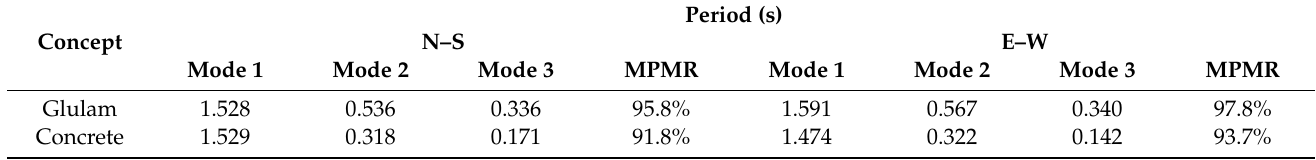
Table 6. Periods associated with the first three modes participating in both principal axes taken from the modal analysis and modal participating mass ratio (MPMR) corresponding to the contribution of the first three modes for each concept.